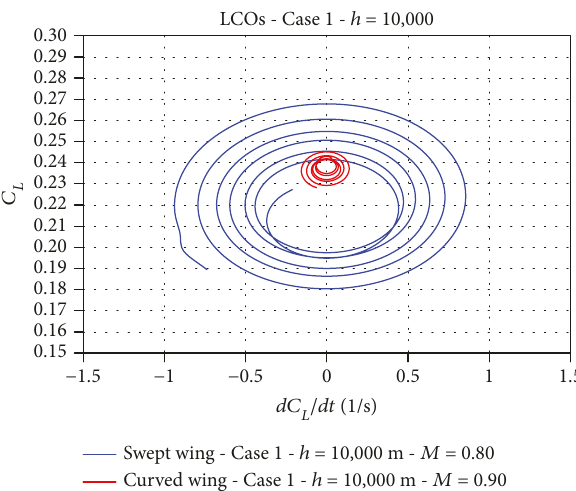
Figure 24: FSI DB — estimation of lift coe ffi cient LCOs (Case 1).